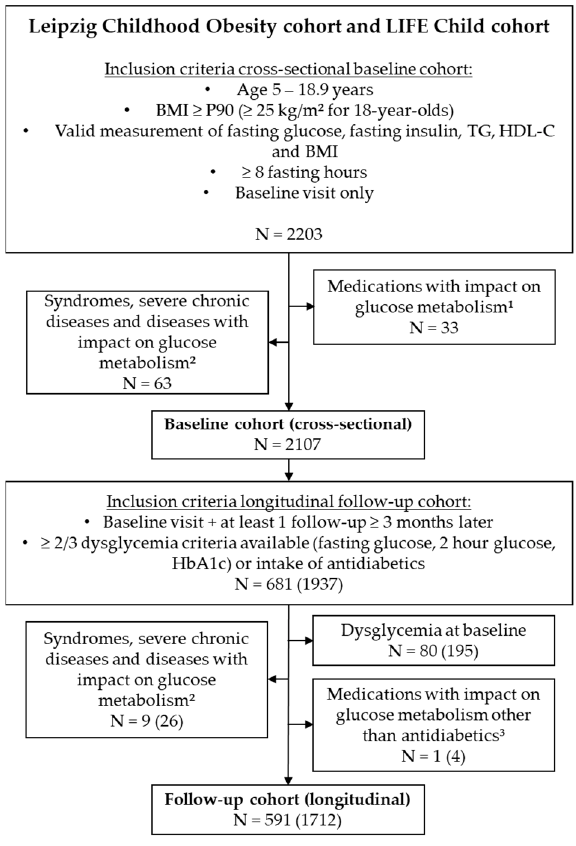
Figure 1. Selection of study population. 1 antidiabetics, growth hormone, systemic glucocorticoids; 2 panhypopituitarism, malignant diseases, bariatric surgery, spinal muscular atrophy, phenylketonuria, pancreatitis, strong developmental delay, cerebral paresis, acute infection, tuberoid sclerosis, pancreatitis, Crohn’s disease, Celiac disease, syndromes (Trisomy 21, Prader Willi syndrome, Bardet Biedl syndrome, Monogenic obesity, 15q13.3 microdeletion syndrome, monogenic diabetes, Beckwith Wiedemann syndrome, Kabuki syndrome, Trichorhinophalangeal syndrome, Klinefelter syndrome, Cowden syndrome, Poland syndrome, Hypochondroplasia); 3 growth hormone, high density lipoprotein cholesterol; 90th percentile; triglycerides.